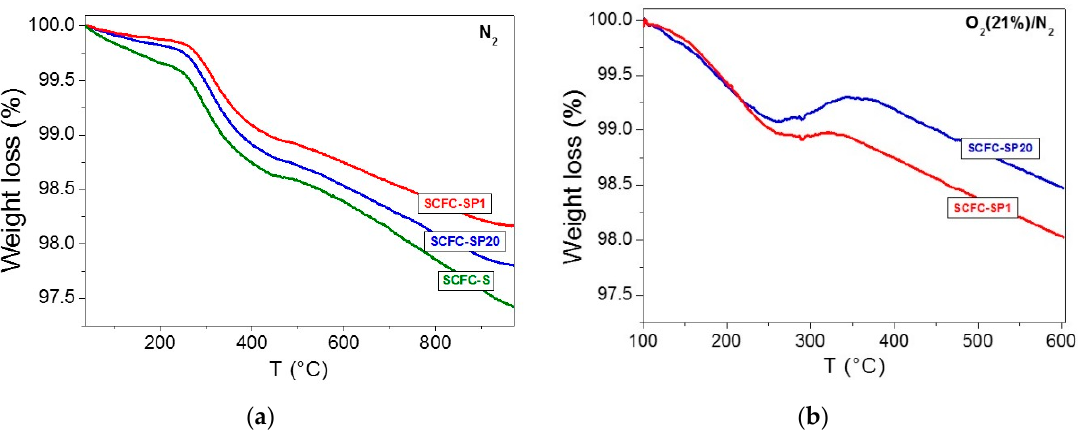
Figure 6. ( a ) Thermogravimetric analyses (TGA) under N 2 flow; ( b ) TGA under O 2 (21%) / N 2 flow (step 3 of Figure S1).